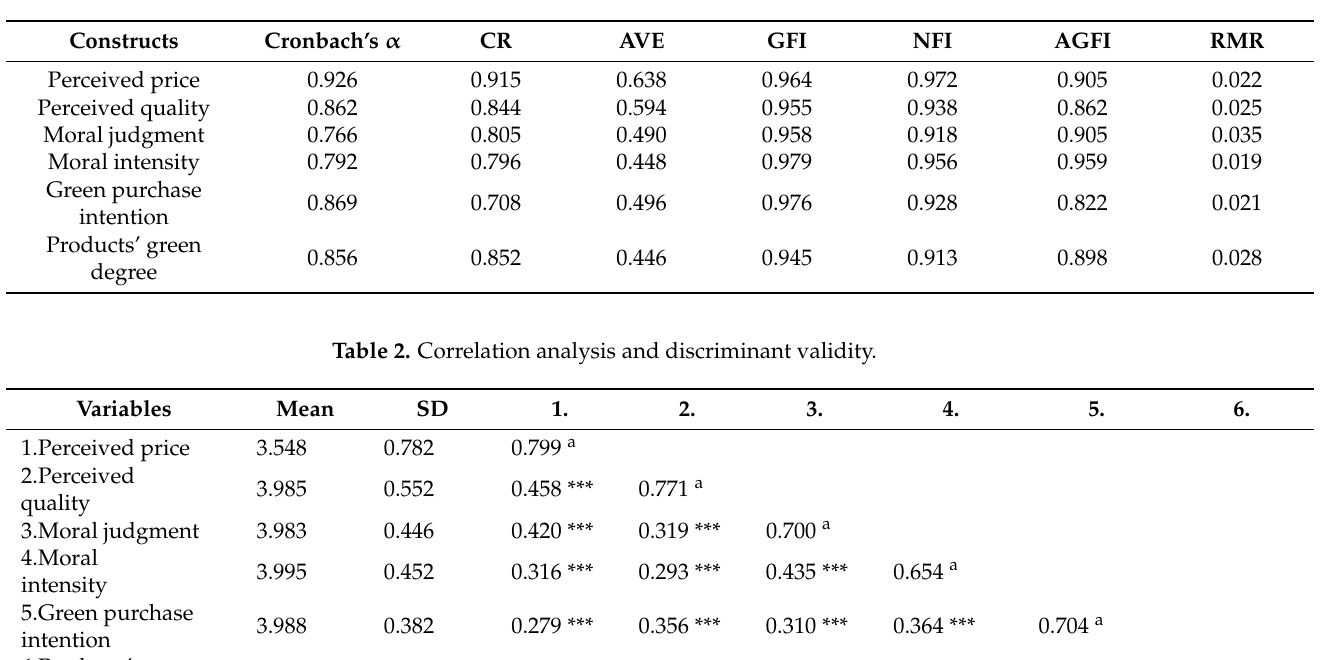
Table 1. Convergent validity analysis.